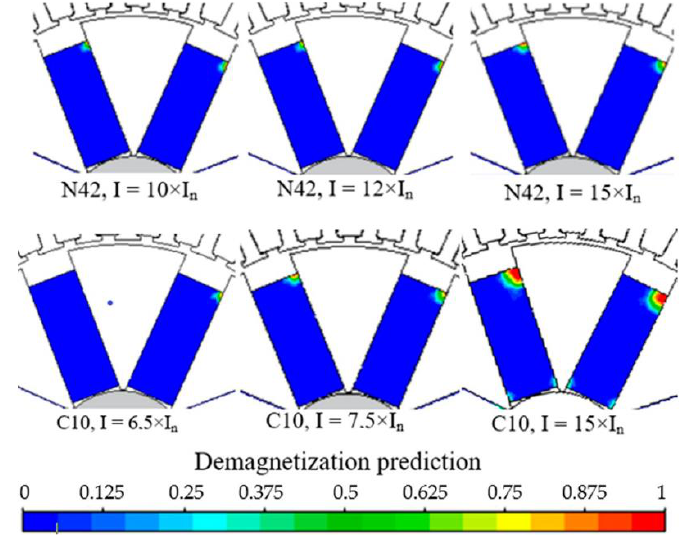
Figure 9. Results of the demagnetization analysis of N42 and C10 magnets in the tangential machine.